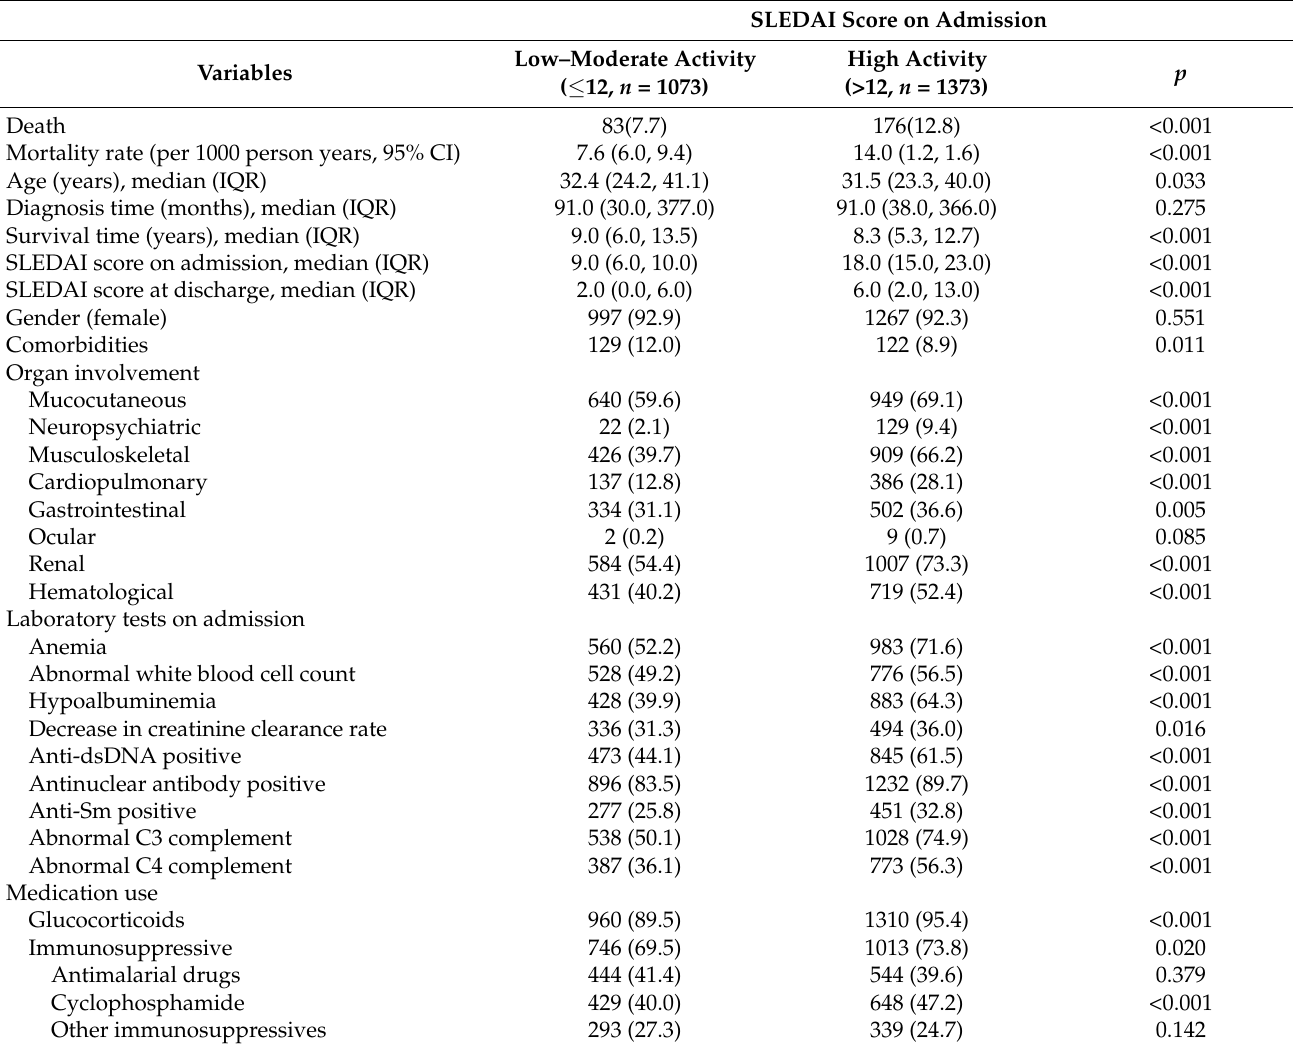
Table 1. Characteristics of study patients with SLE by initial SLEDAI score on